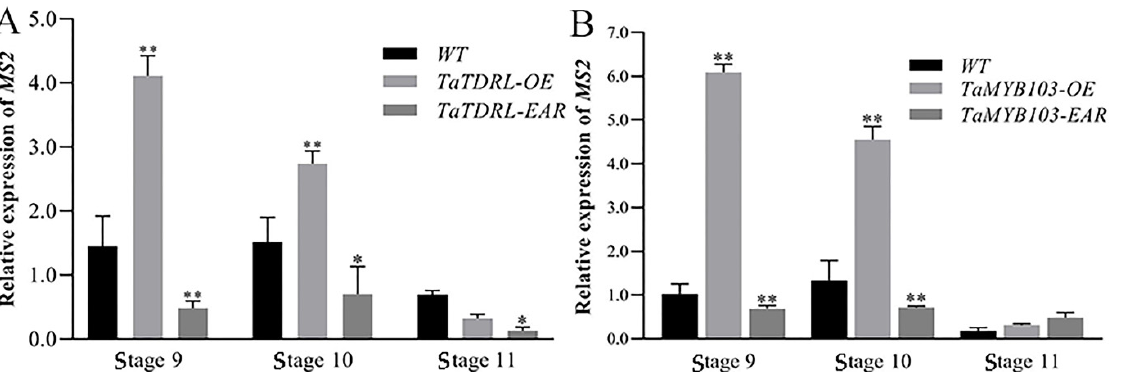
Figure 7. The expression levels of the AtMS2 gene in transgenic Arabidopsis and wild-type plants. ( A ) The expression levels of AtMS2 in wild-type (WT), TaTDRL-OE, and TaTDRL-EAR plants. ( B ) The expression levels of AtMS2 in WT, TaMYB103-OE, and TaMYB103-EAR plants. Stage 9 to Stage 11: Anther development stages in Arabidopsis . The significance of differences was assessed using the Student’s t -test. * p < 0.05, ** p <